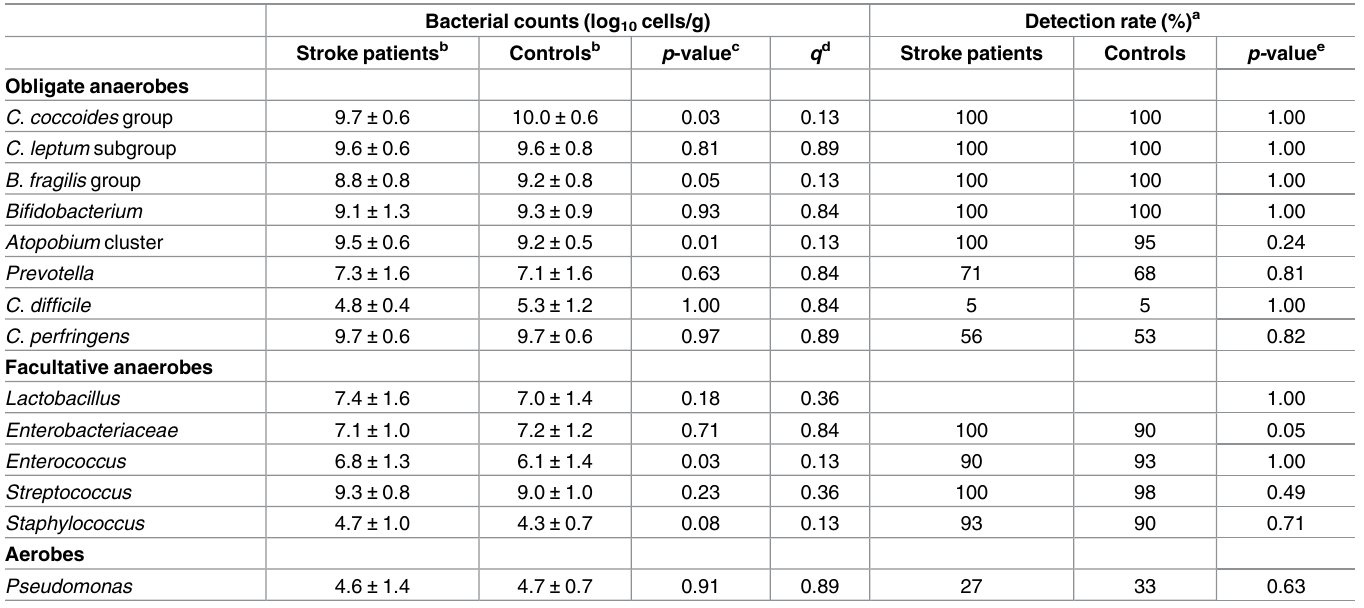
Table 2. Comparisons of fecal bacterial counts between stroke patients and control subjects.